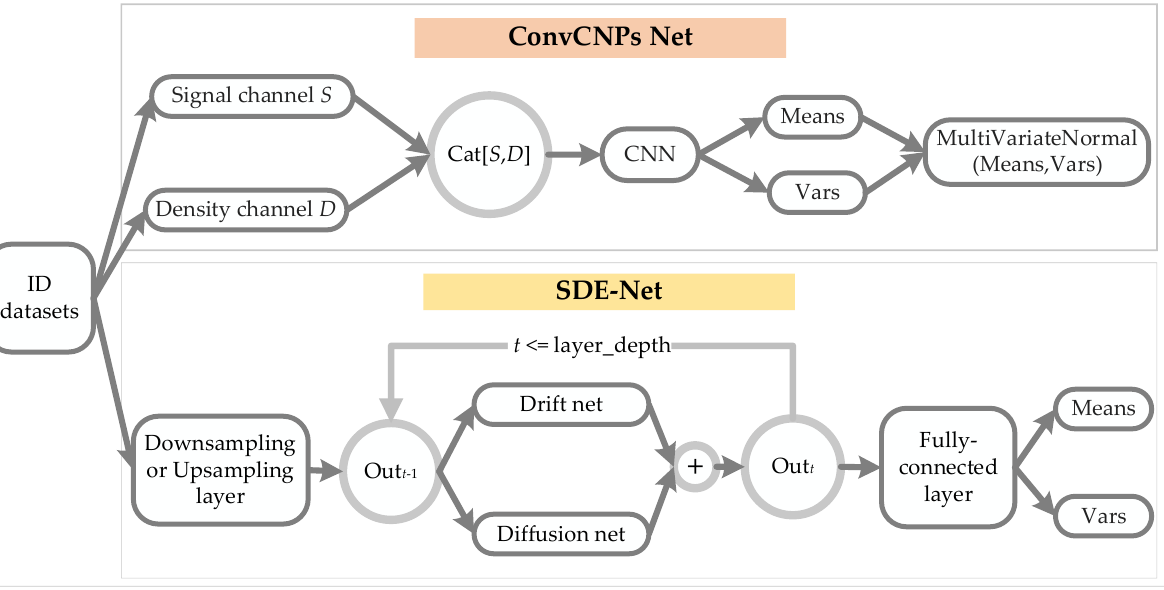
Figure 3. Architecture of the ConvCNPs – SDE model. ID datasets were used to train ConvCNPs-Net and SDE-Net.